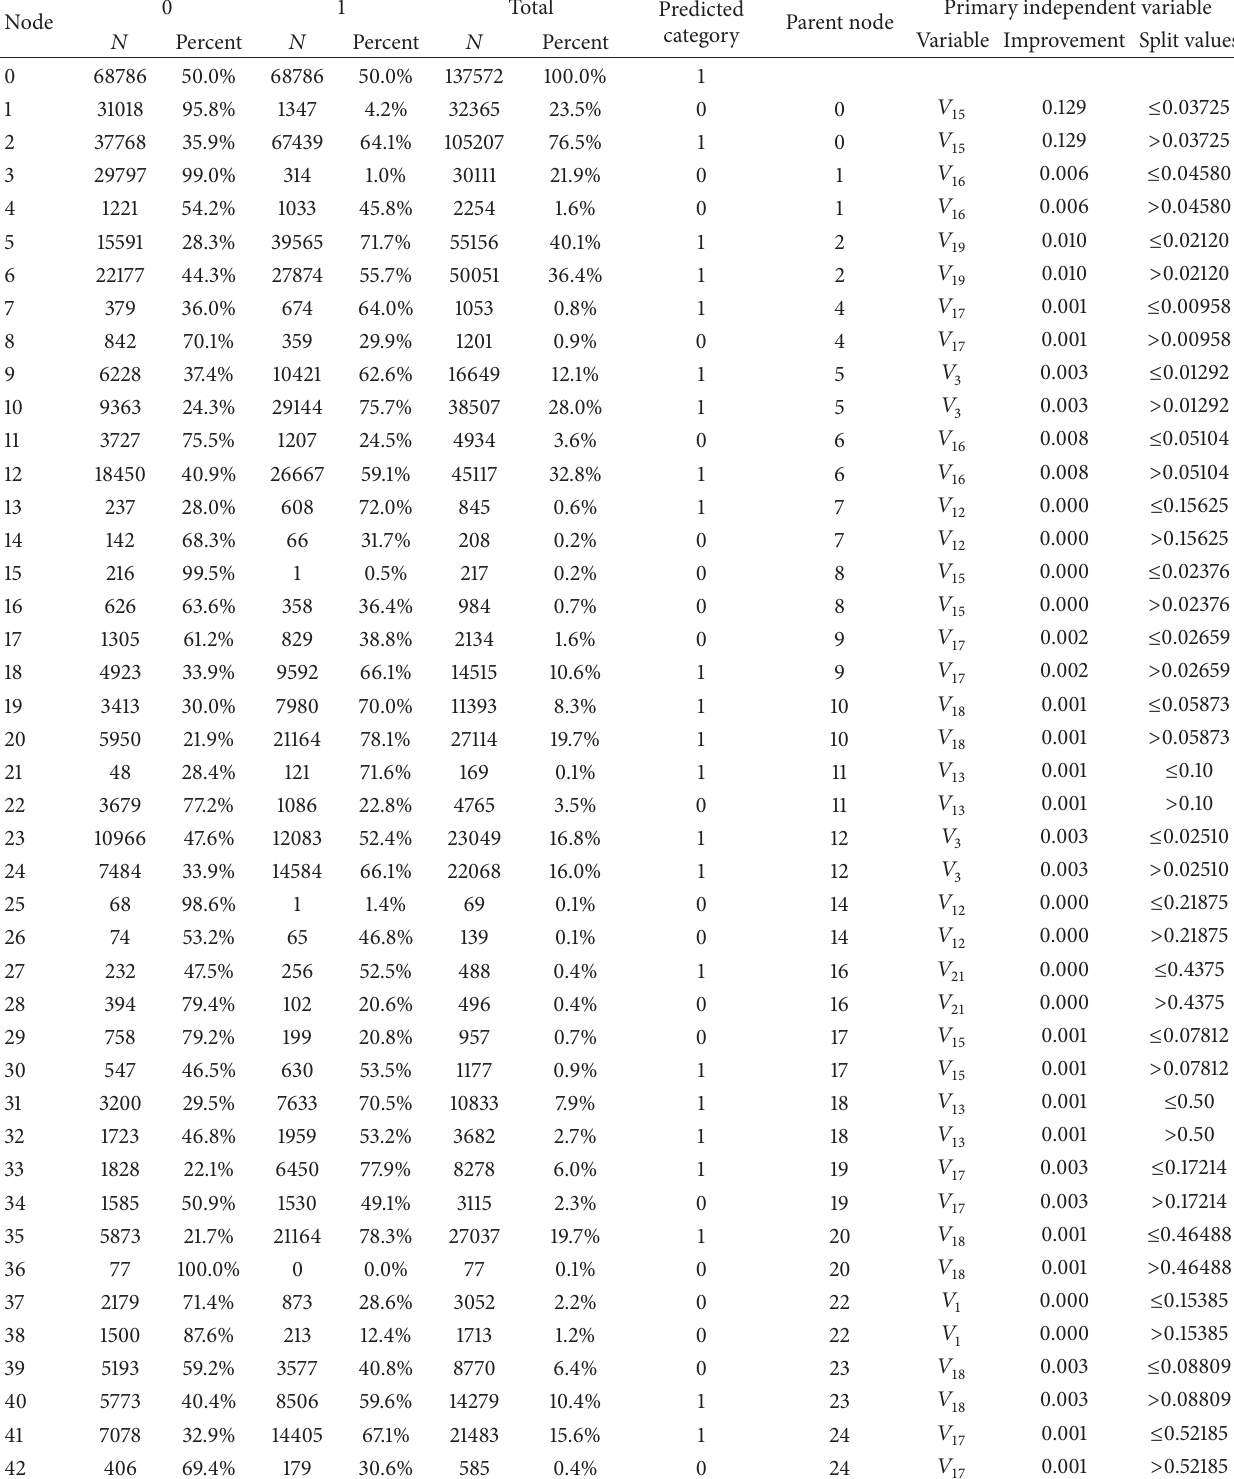
Table 2: Tree table using CRT